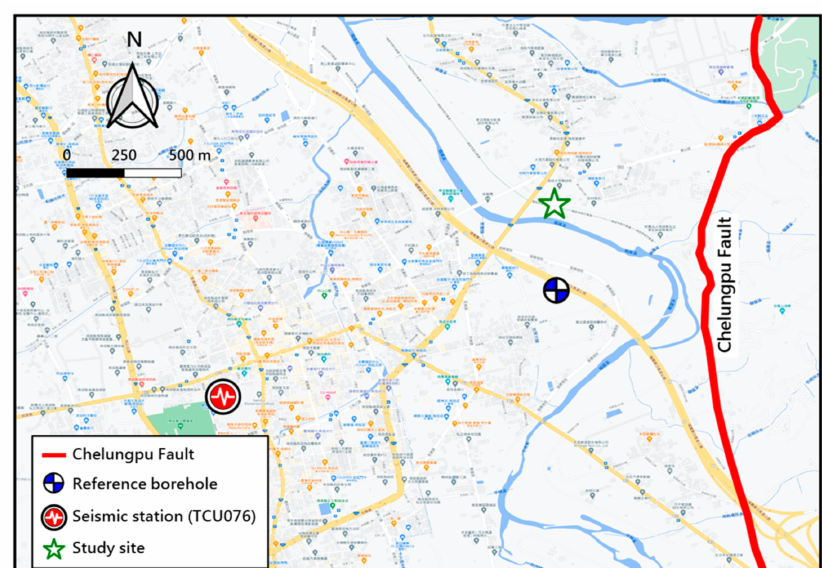
Figure 11. The location of the demonstration site.